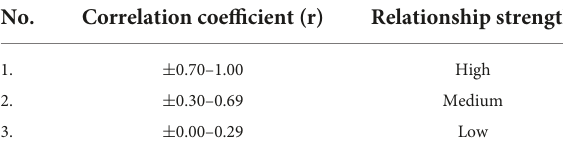
TABLE 2 The relationship between the two constructs (Jackson,